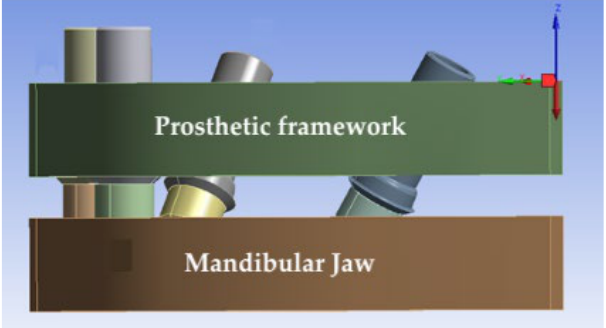
Figure 3. The mandible model and the prosthetic framework connecting the extragrade abutments to the OT-Equator attachments. The load is applied on the framework cantilever and is indicated in red.